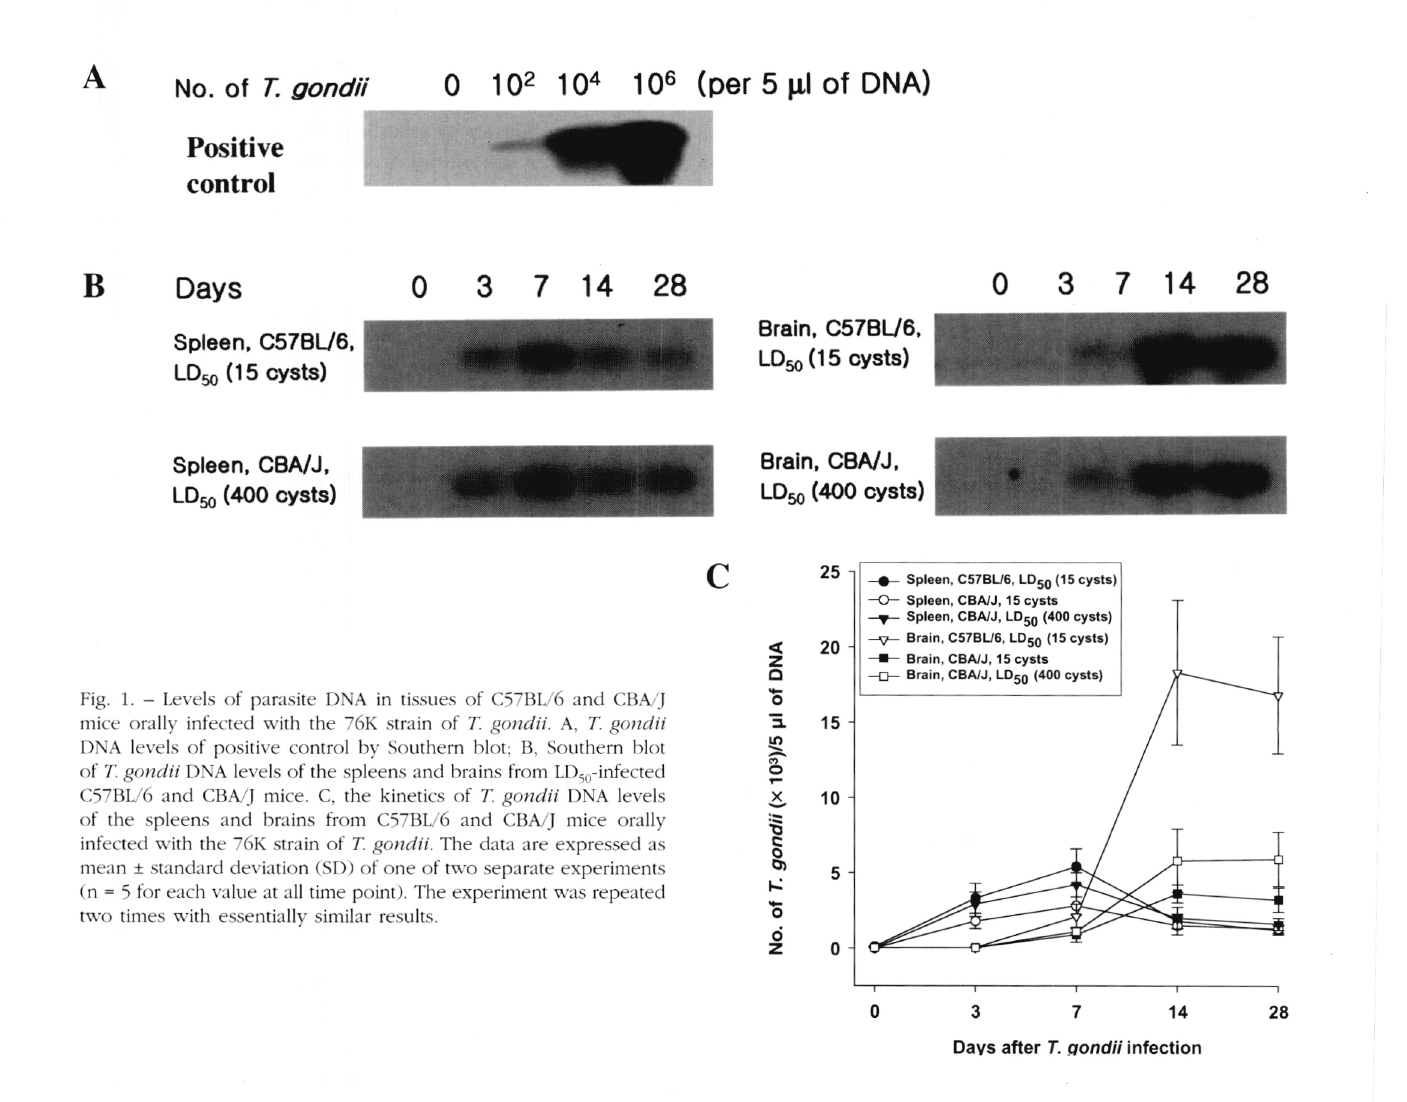
Fig. 1. - Levels of parasite DNA in tissues of C57BL/6 and CBA/J mice orally infected with the 76K strain of T. gondii. A, T. gondii DNA levels of positive control by Southern blot; B, Southern blot of T. gondii DNA levels of the spleens and brains from LD50-infected C57BL/6 and CBA/J mice. C, the kinetics of T. gondii DNA levels of the spleens and brains from C57BL/6 and CBA/J mice orally infected with the 76K strain of T. gondii. The data are expressed as mean ± standard deviation (SD) of one of two separate experiments (n = 5 for each value at all time point). The experiment was repeated two times with essentially similar